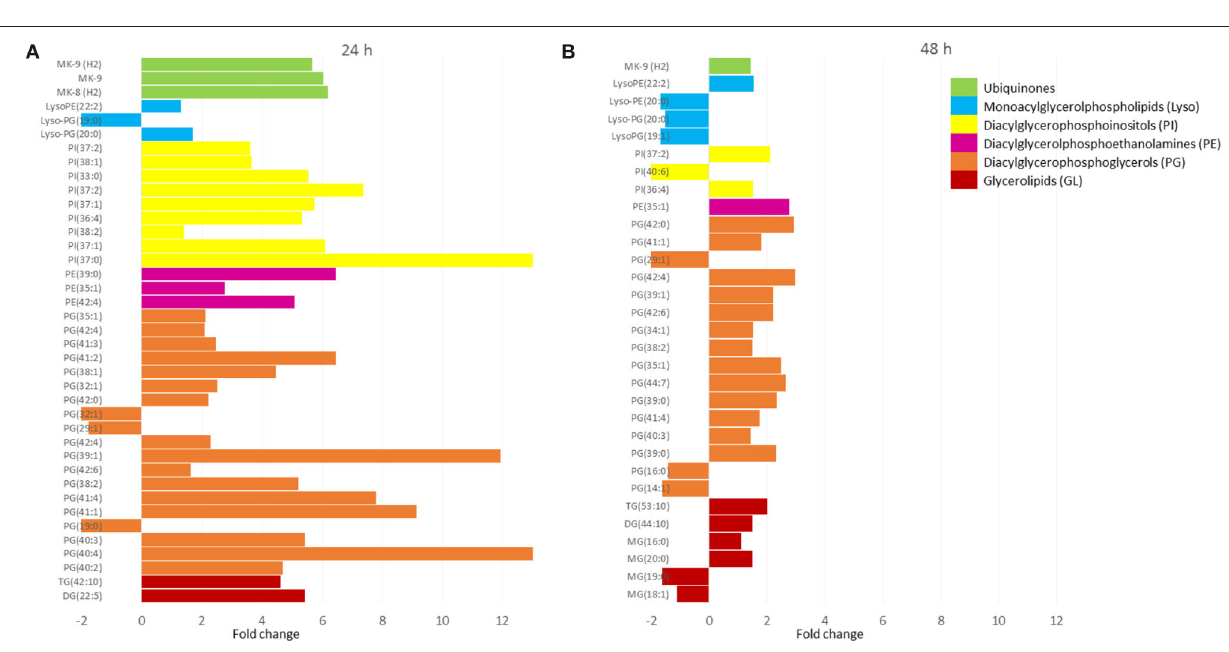
Frontiers in Microbiology |